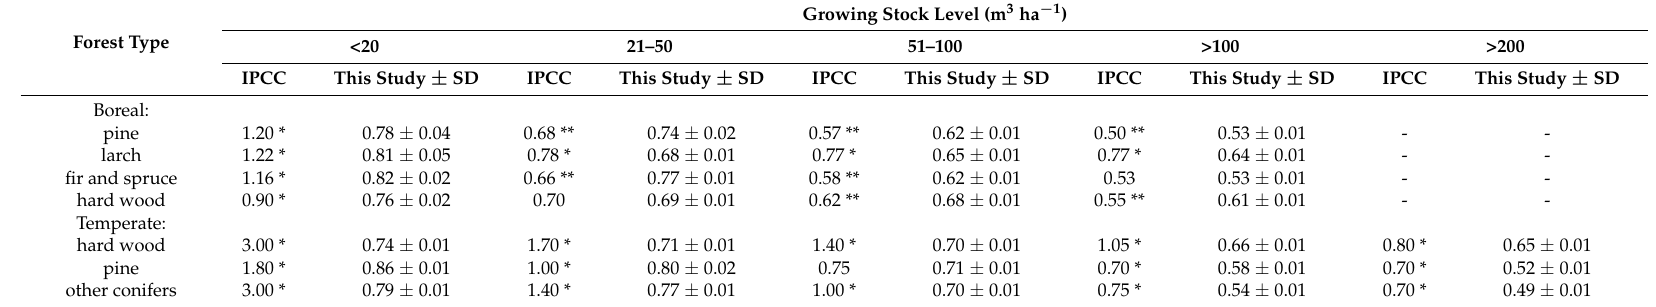
Table 3. Comparison of BCEF (t m − 3 ) default values from the IPCC 2006 report with BCEFs calculated using our approach.